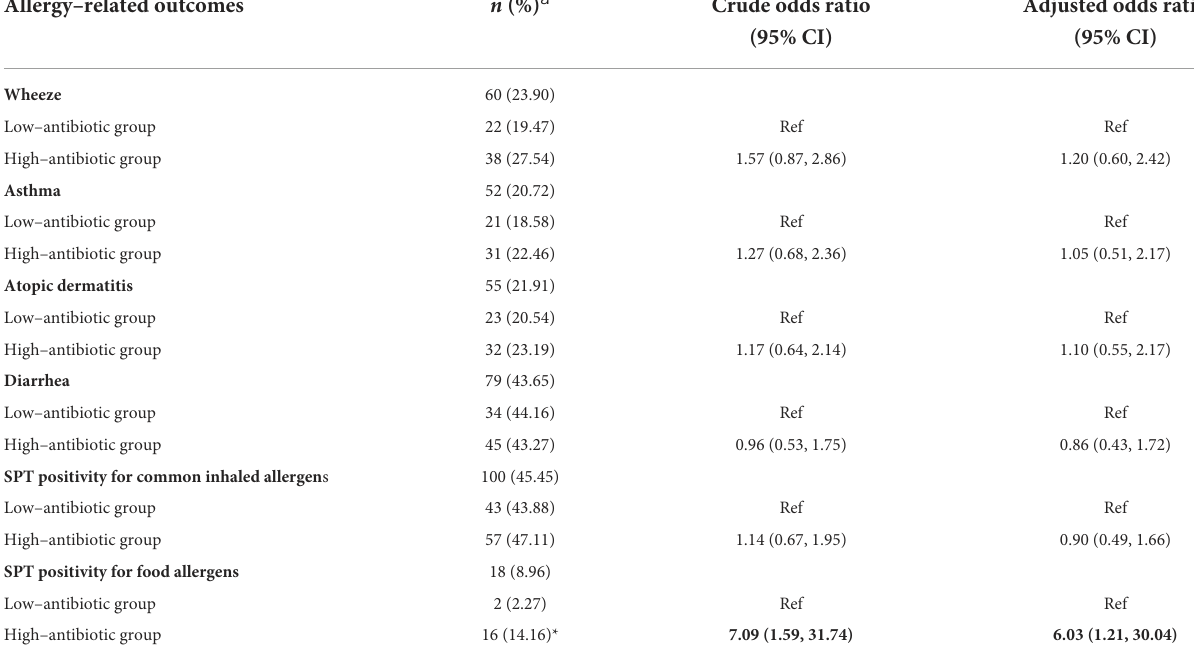
TABLE 3 The associations of high maternal urinary antibiotic concentrations with allergic diseases, skin prick test positivity for food allergens and common inhaled allergens at age 5 years, and diarrhea at age 2 years. Allergy–related